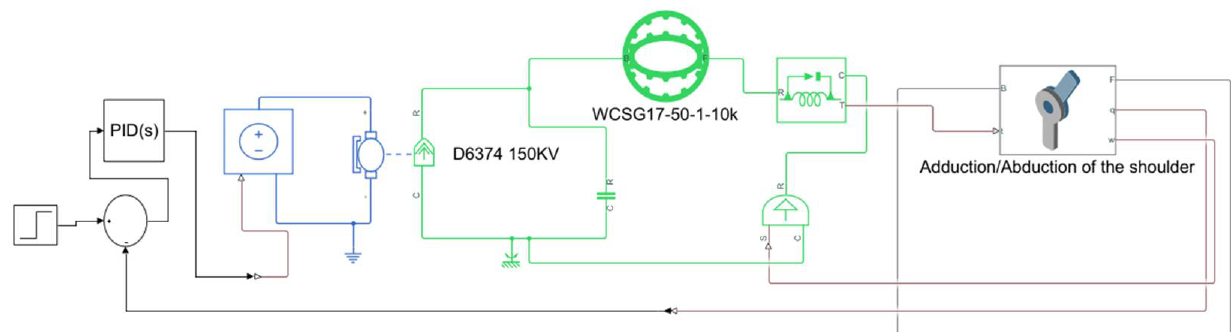
Table 6. Simulation dynamics responses of SAMA exoskeleton.